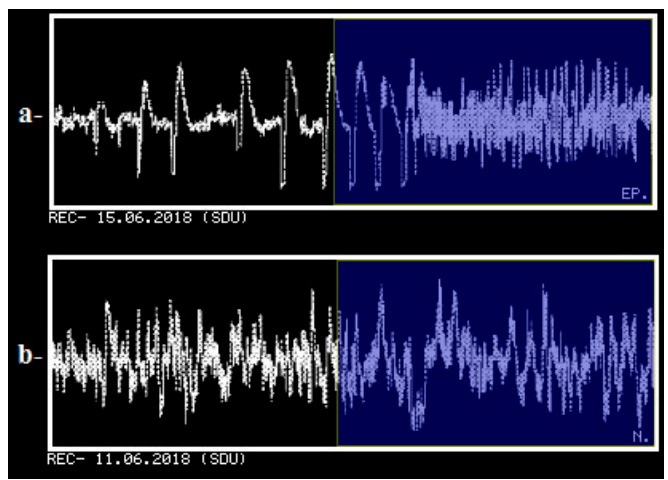
Figure 10. ( a ) Early epilepsy seizure diagnosis done with the ANN–ALO approach at the Hospital of SDU; and ( b ) normal patient EEG prediction done with the ANN–ALO approach at the Hospital of SDU.